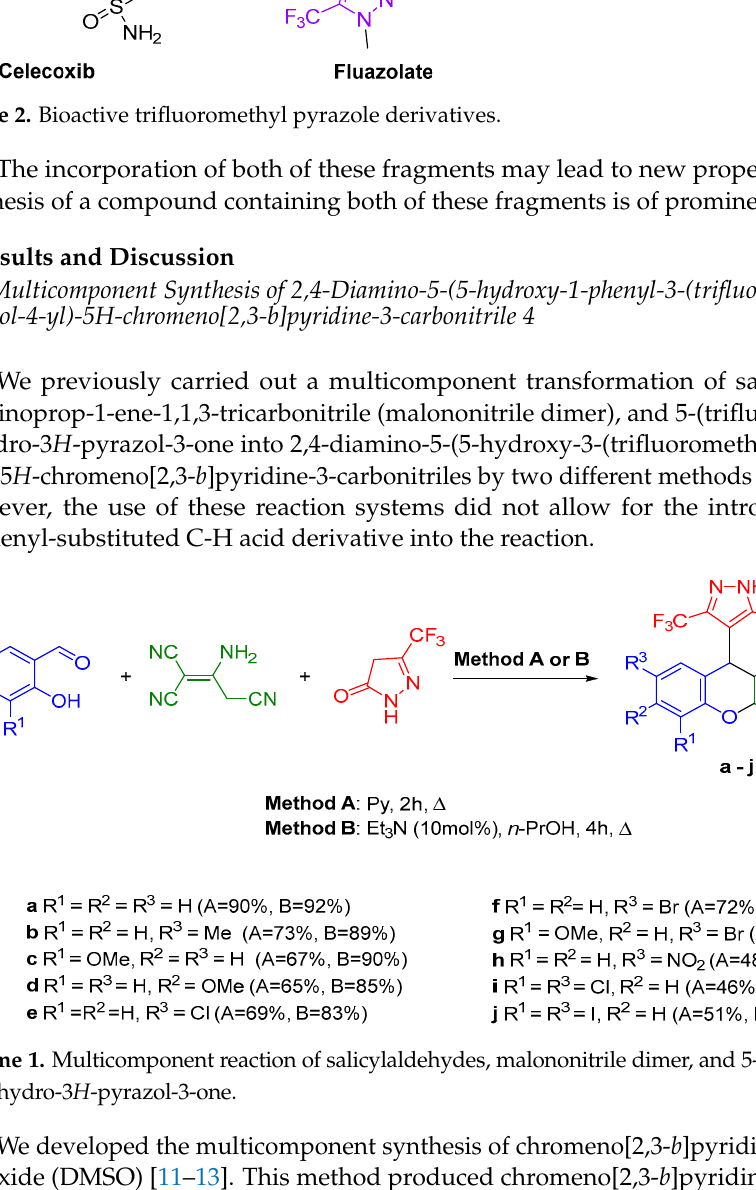
Scheme 1. Multicomponent reaction of salicylaldehydes, malononitrile dimer, and 5-(trifluorome-